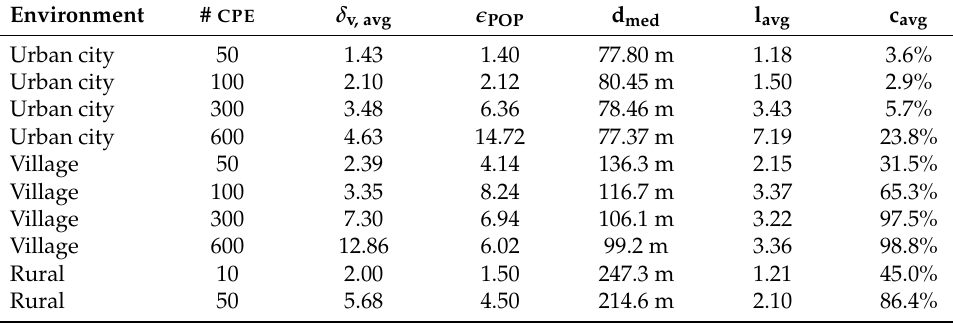
Table 5. FWA network characterization for different environments and network densities, with δ v, avg the average CPE vertex degree, (cid:101) POP the POP eccentricity, d med the median link distance in meter, l avg the average path length towards the POP in hop count, and c avg the average percentage of connected CPE devices without adding any EDGE